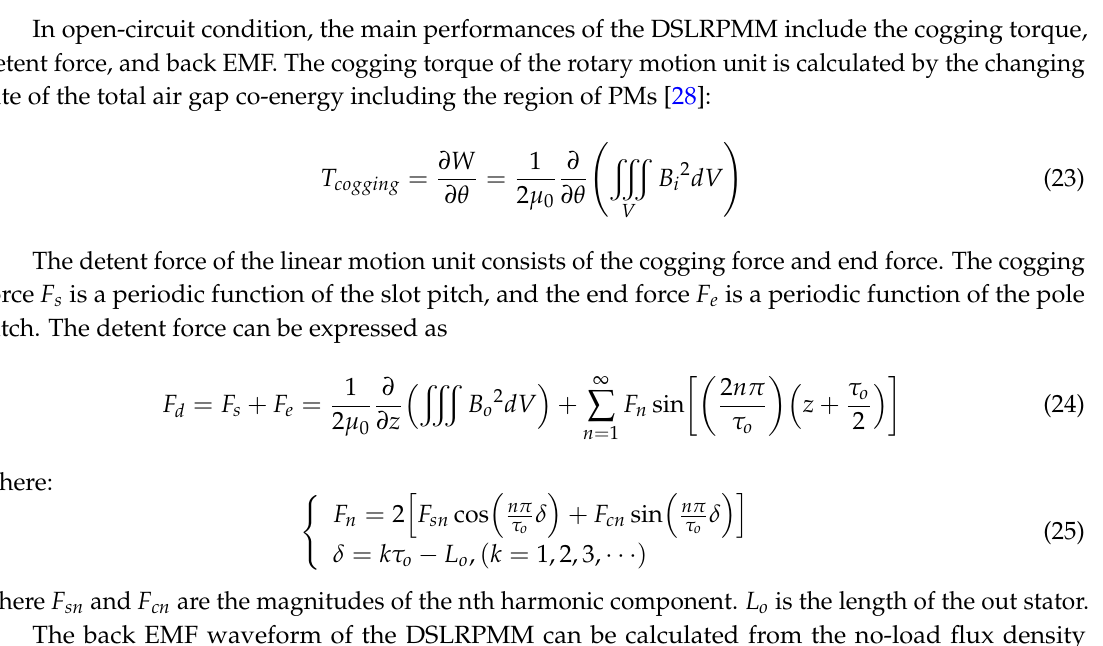
Figure 8. Relation between the magnetic field intensity and relative permeability of the used mover core material.